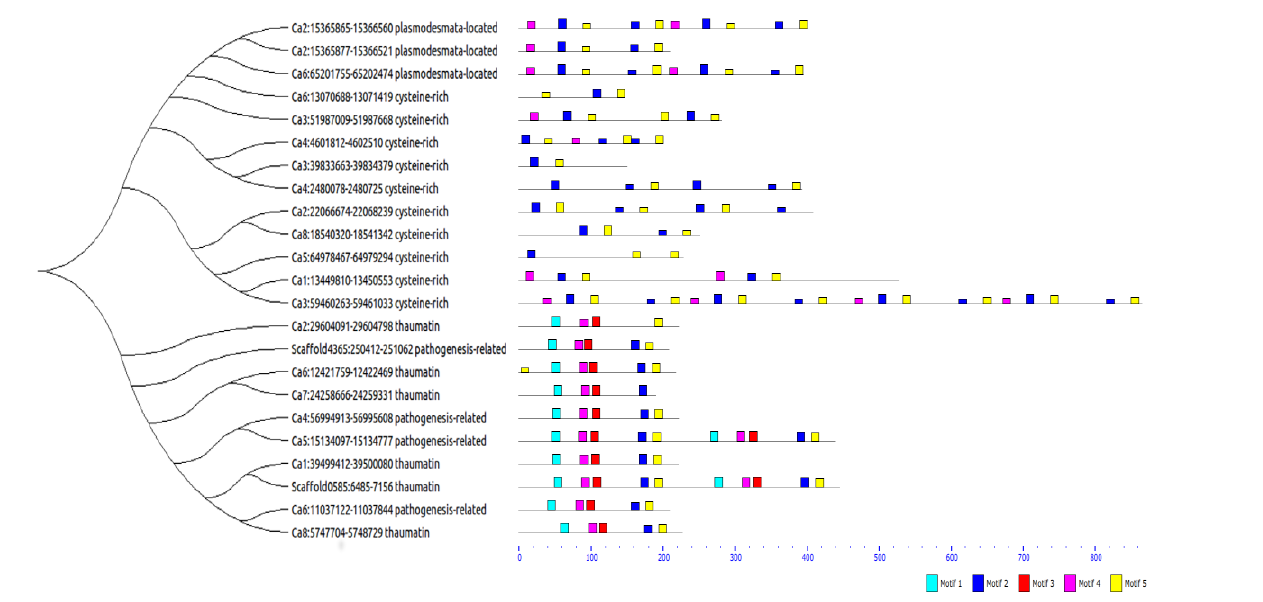
Figure 6 : The phylogenetic analysis of chickpea anti-fungal proteins, where the protein motif structures are shown as detected using MeMe